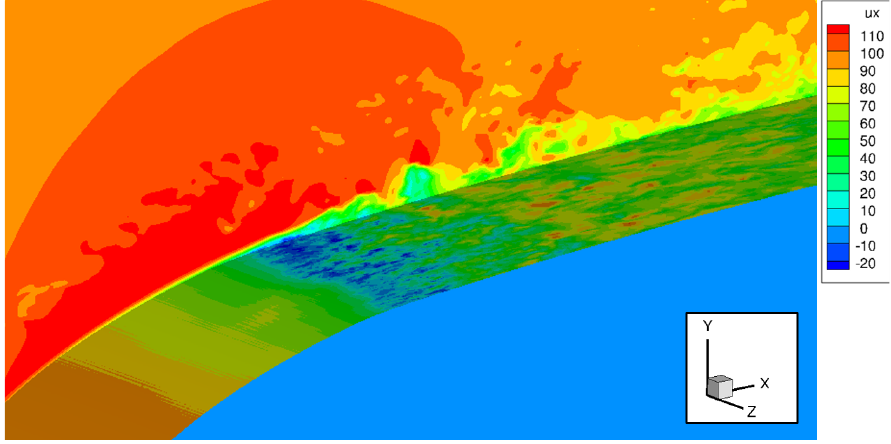
Figure 7. The leading edge separation bubble around x / c = 0.15 in the fine grid simulation; color shows velocity component u x at the nearest cell from the airfoil surface and an x , y cross-section. Figures 8a and 9 show the instantaneous and time-averaged distribution of the velocity component u x , respectively, around the flap when θ = 5.5 ◦ .